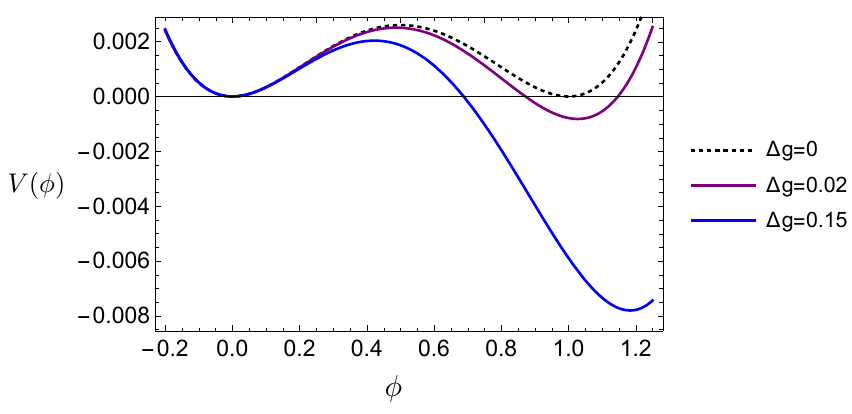
Figure 3 . Potential shape for m = 1 = 2 p 3, (cid:21) = 1. The dashed line represents (cid:1) g = 0 for which the two vacua degenerate, and the potentials with the purple and blue lines lead to a thin-wall and thick-wall bubbles,